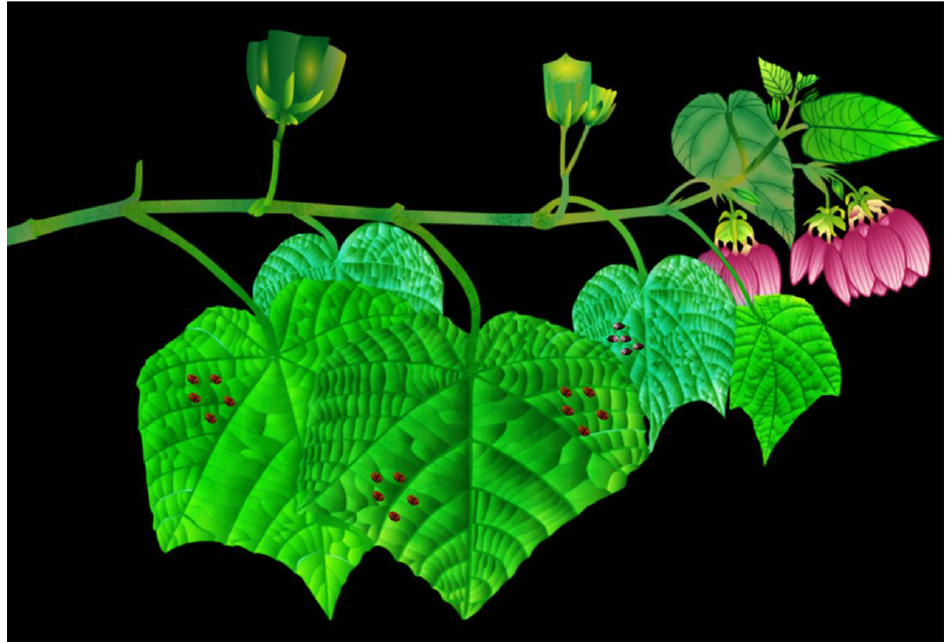
Figure 6. Hypothetical reconstruction of the whitefly puparia-mediated angiosperm leaf.